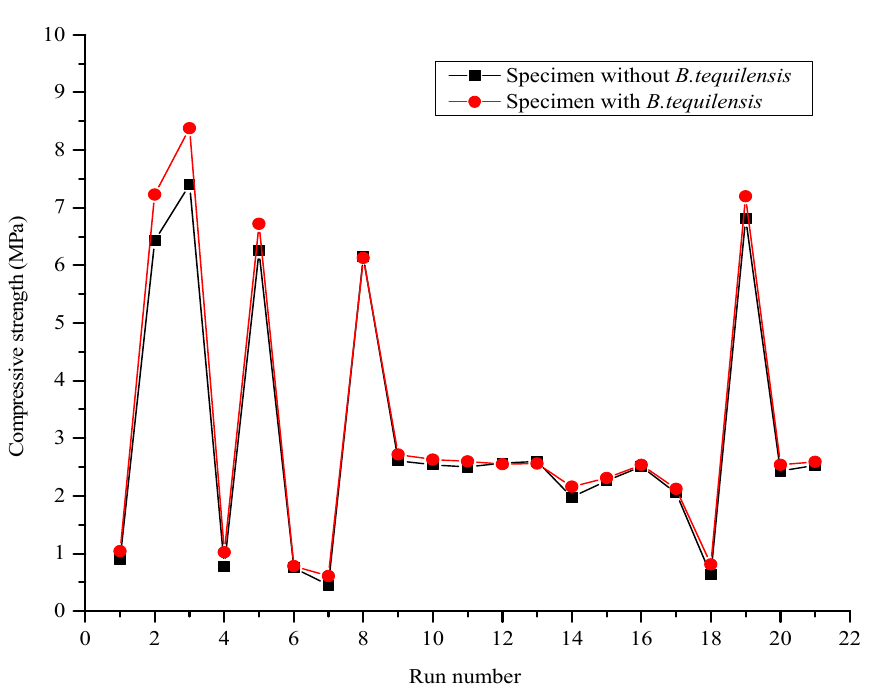
Figure 7. Compressive strength of FCB and